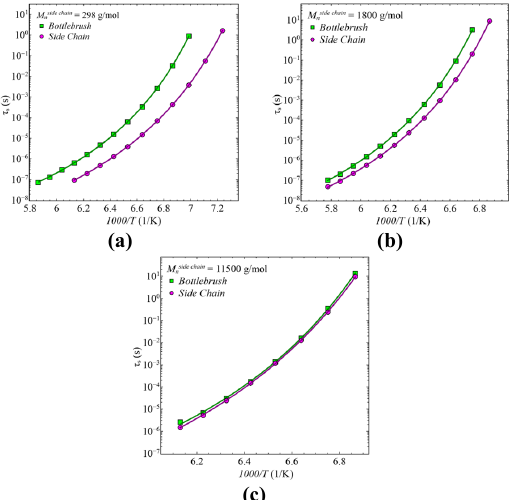
(c) Fig. 6. Segmental relaxation time, 𝜏 (cid:3046) , as a function of 1000/ 𝑇 for each bottlebrush polymer in comparison with their respective single linear side chain. (a) Sample 1, (b) Sample 2, and (c) Sample 3. Solid lines are the best description with the VFT equation. Data has been previously published in Jakobi et al .[15]